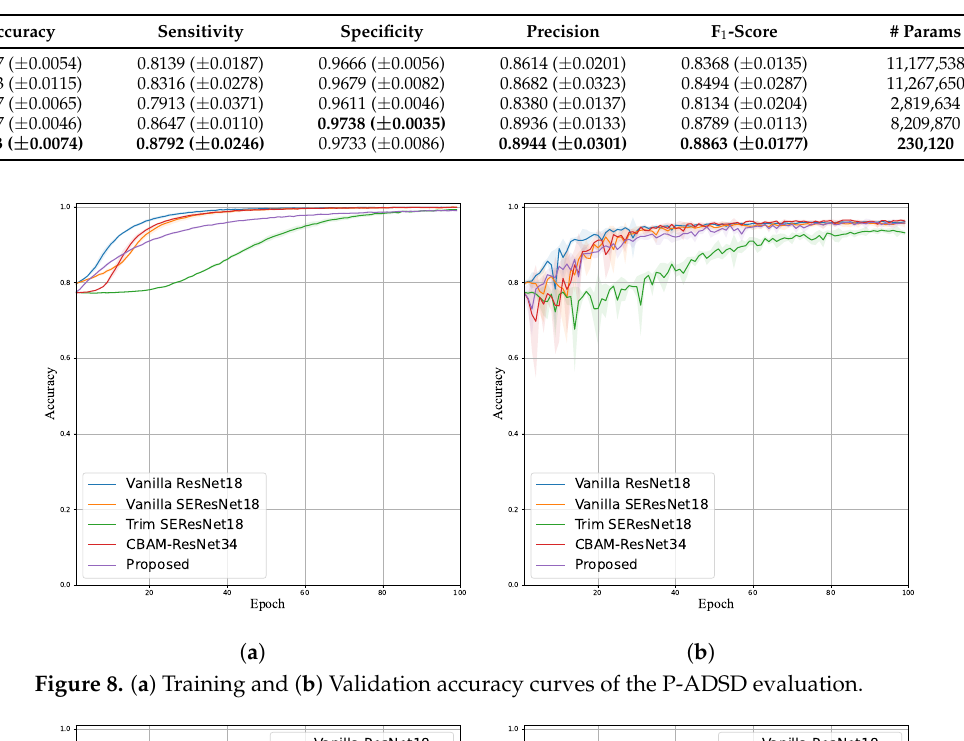
Table 5. Performance comparison on the P-ADSD dataset.